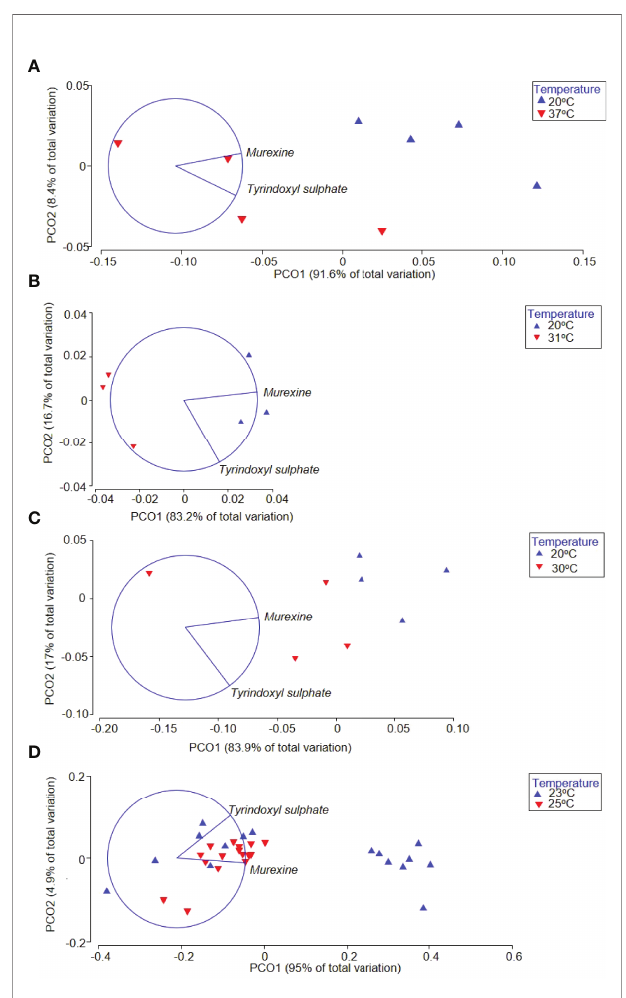
FIGURE 5 | Principal component ordination (PCO) based on a Euclidian distance similarity matrix on the secondary metabolite composition from the hypobranchial gland of Dicathais orbita , with vector overlay from Pearson correlation > 0.9. (A) Critical Thermal Maxima (CTMax) short-term fast warming rate with temperature increment of 1°C/1 h; (B) Critical Thermal Maxima (CTMax) longer-term with slow warming rate temperature increment of 1°C/12 h; (C) 7 day static heat stress; and (D) 35 day ocean climate change